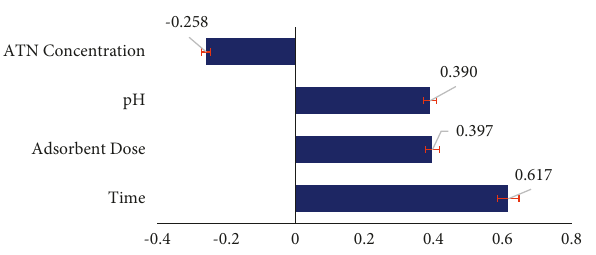
Figure 4: Tornado diagram for sensitivity analysis by the Monte Carlo method.